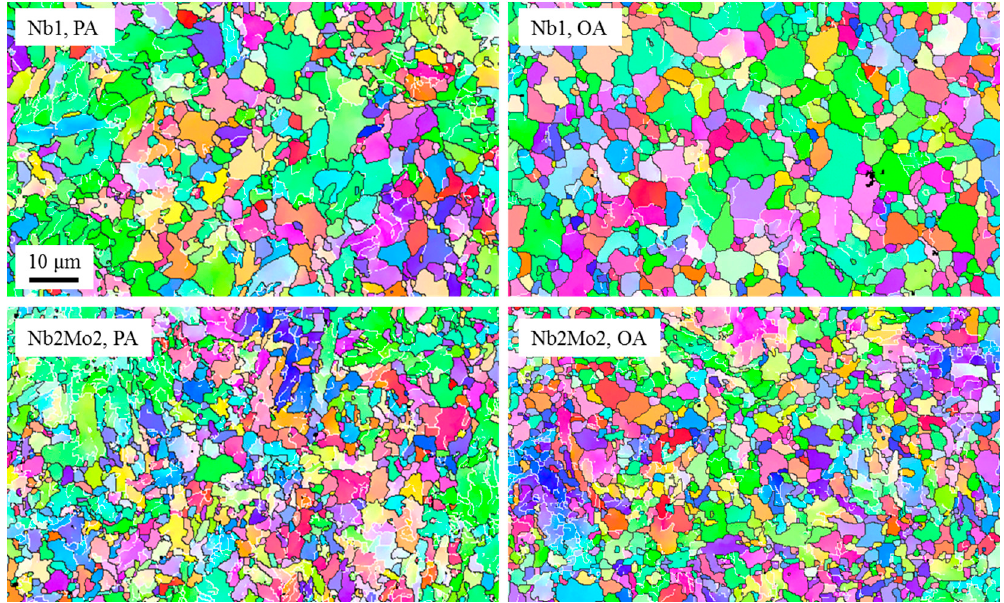
Figure 7. EBSD IPF maps of the Nb1 and Nb2Mo2 steels peak-aged (PA), 15 min at 630 °C, (Nb1, PA and Nb2Mo2, PA) and over-aged (OA), 690 min at 630 ° C (Nb1, OA and Nb2Mo2, OA).